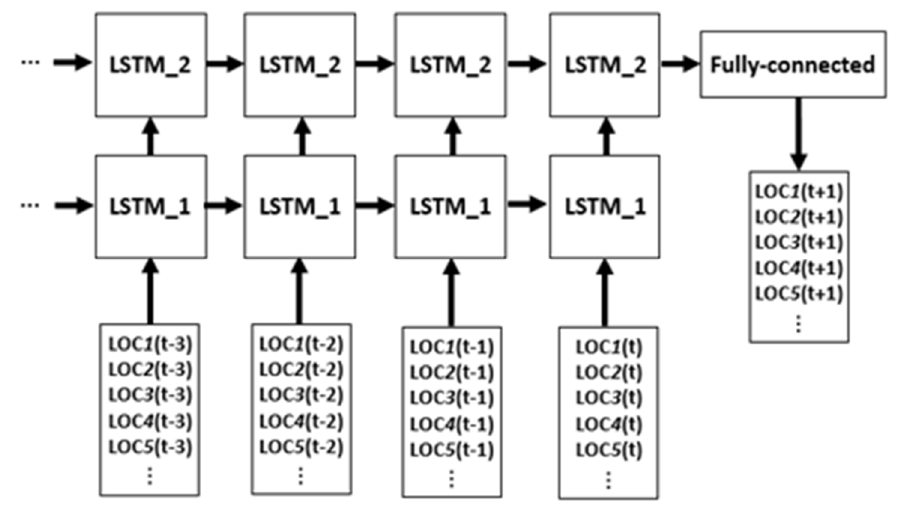
Figure 2. Visual overview of the modeling conceptual architecture.